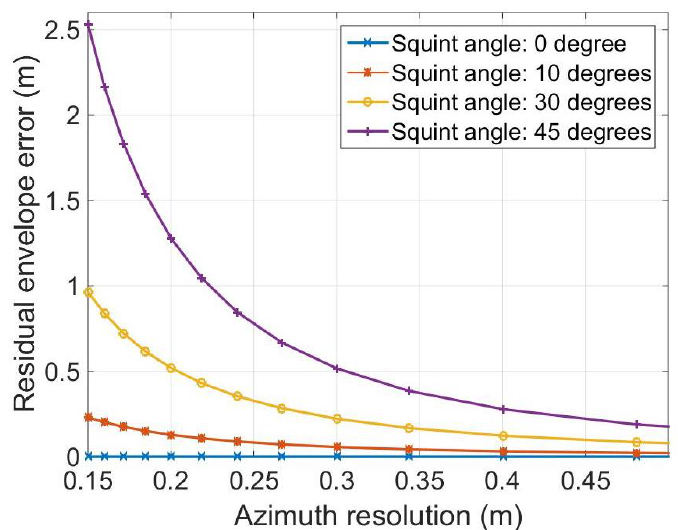
Figure 3. Residual envelope error of the target under 9